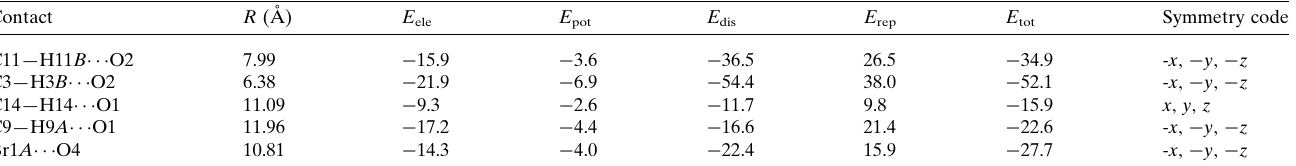
Table 3 Summary of interaction energies (kJ mol (cid:5) 1 ) calculated for the title compound. Contact R (A˚ ) E ele E pot E dis E rep E tot Symmetry code